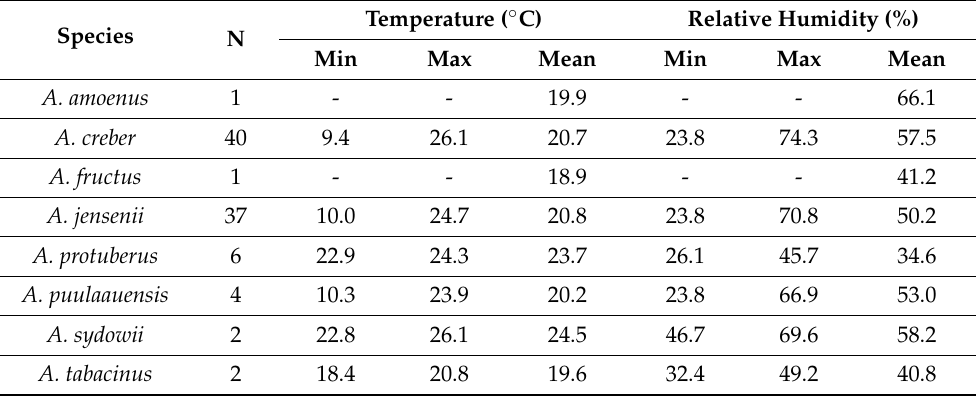
Table 1. Temperature and relative humidity measured during bioaerosols’ collection.